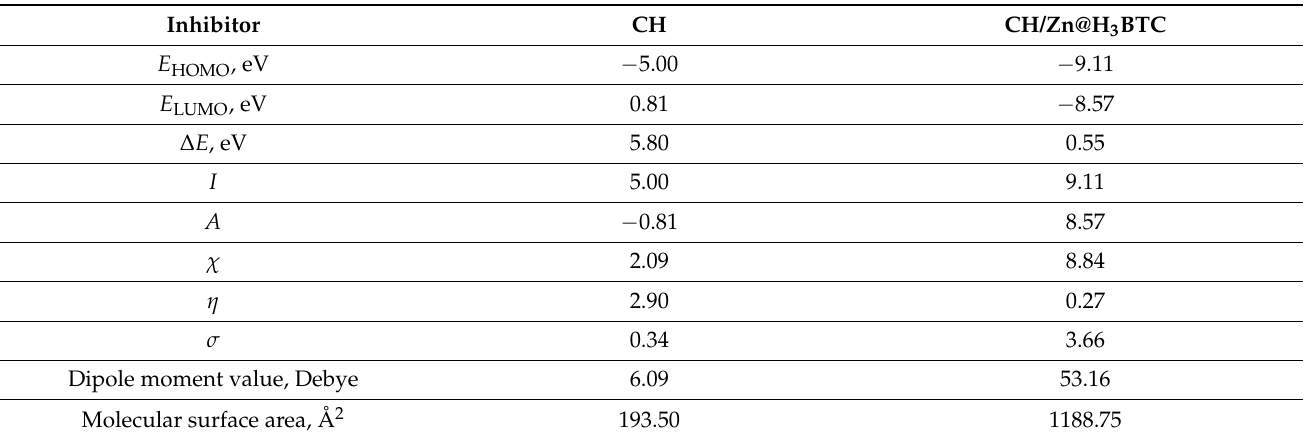
Table 3. The calculated quantum chemical parameters for the monomer structures of CH